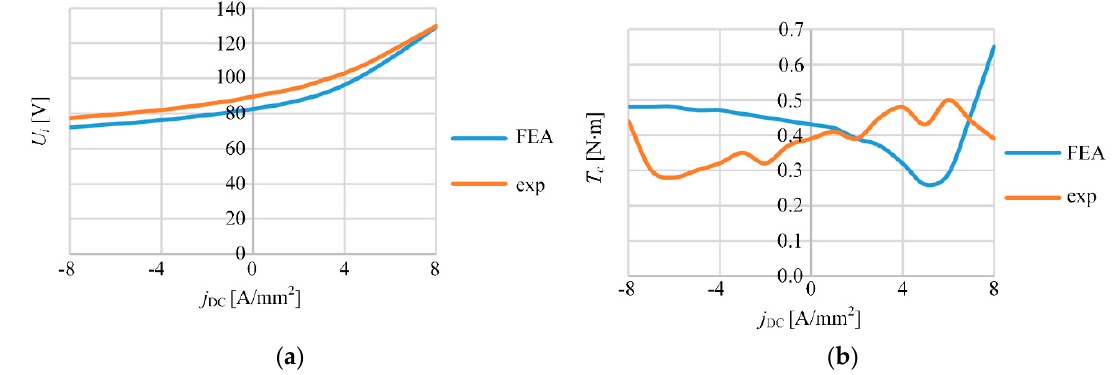
Figure 23. ( a ) RMS values of back-EMF; ( b ) Maximum values of cogging torque [59].